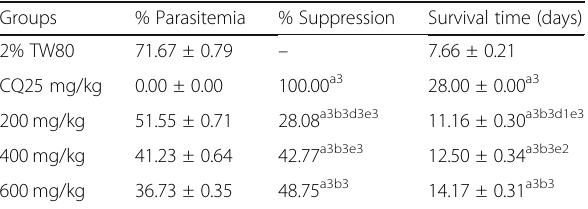
Table 5 Parasitemia and survival time of infected mice treated with 80% methanol extract of the leaves of Olea europaea